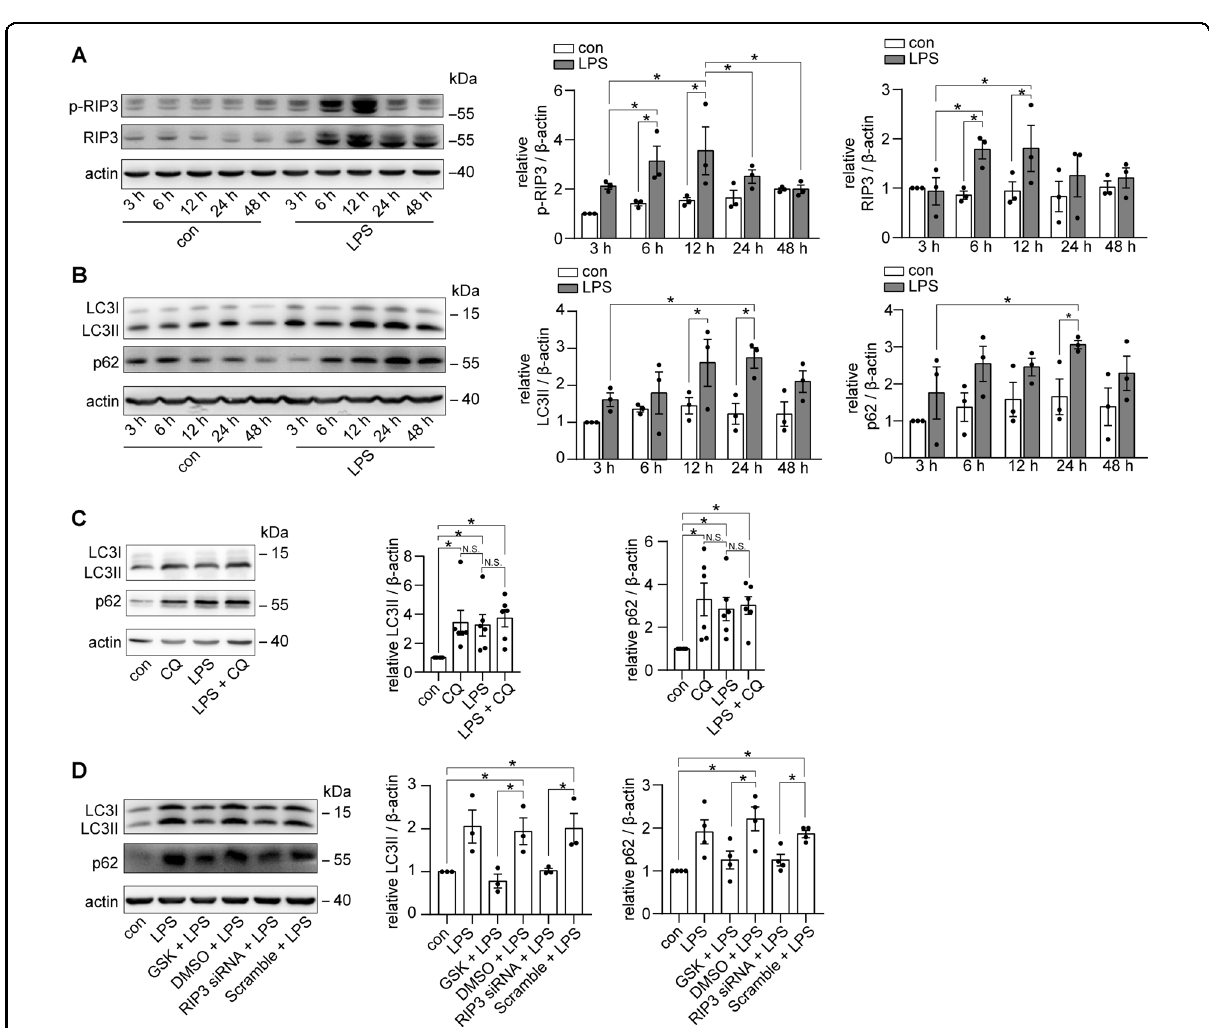
Fig. 3 RIP3 activation inhibited autophagic degradation in LPS-induced cultured PTECs. A , B Cultured PTECs were treated with DMSO or LPS for different time points as indicated. A Immunoblotting showed that the expression of p-RIP3 and RIP3 was increased at 6 and 12 h LPS treatment ( n = 3). B Immunoblotting showed an increase in the expression of LC3II and p62 at 24 h LPS treatment ( n = 3). C Cultured PTECs were treated with the lysosome inhibitor chloroquine (CQ), LPS, or LPS plus CQ for 24 h. Immunoblotting showed that the addition of CQ did not further increase the levels of LC3II and p62 in LPS-treated PTECs ( n = 6). D Immunoblot of LC3 and p62 in cultured PTECs treated with LPS, LPS plus GSK ’ 872 (GSK), LPS plus DMSO, LPS plus RIP3 siRNA, or LPS plus scrambled siRNA (scramble) for 24 h. GSK or RIP3 siRNA downregulated the LPS-induced increase of LC3II and p62 ( n = 3 – 4). * P < 0.05. NS for nonsigni fi